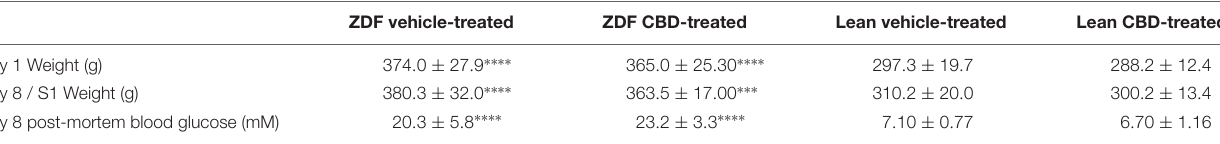
TABLE 1 | Body weights (g) of ZDF Lean and ZDF rats recorded prior (day 1) and after (day 8) daily i.p. injection of vehicle or 10 mg/kg CBD.